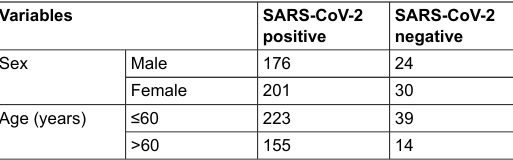
Table 1: The baseline characteristics